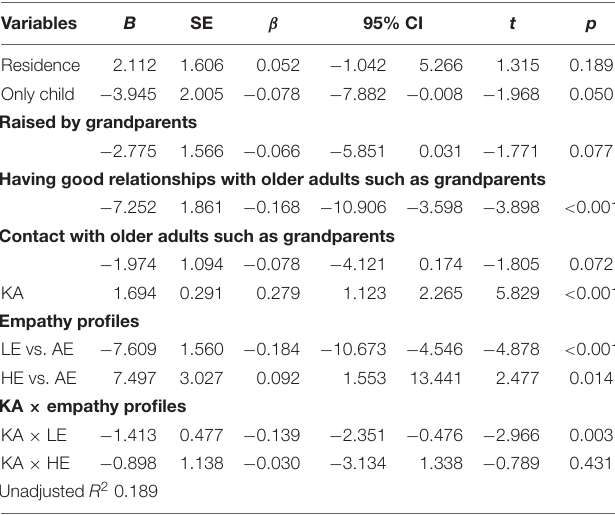
TABLE 5 | Regression analysis predicting KAOP from KA and empathy